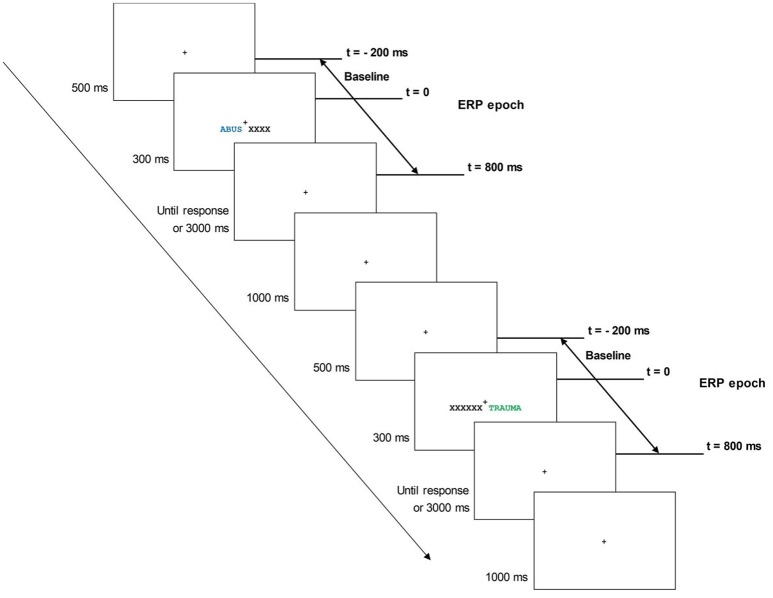
Sequence of events in the emotional Stroop task. Each trial began with a fixation cross of 500 ms, followed by a bilateral presentation of experimental stimuli for 300 ms. Then, the participant had to indicate manually the color of the colored item. After participants had responded, or after 3,000 ms had elapsed, a 1,000 ms wait followed and the next trial started.